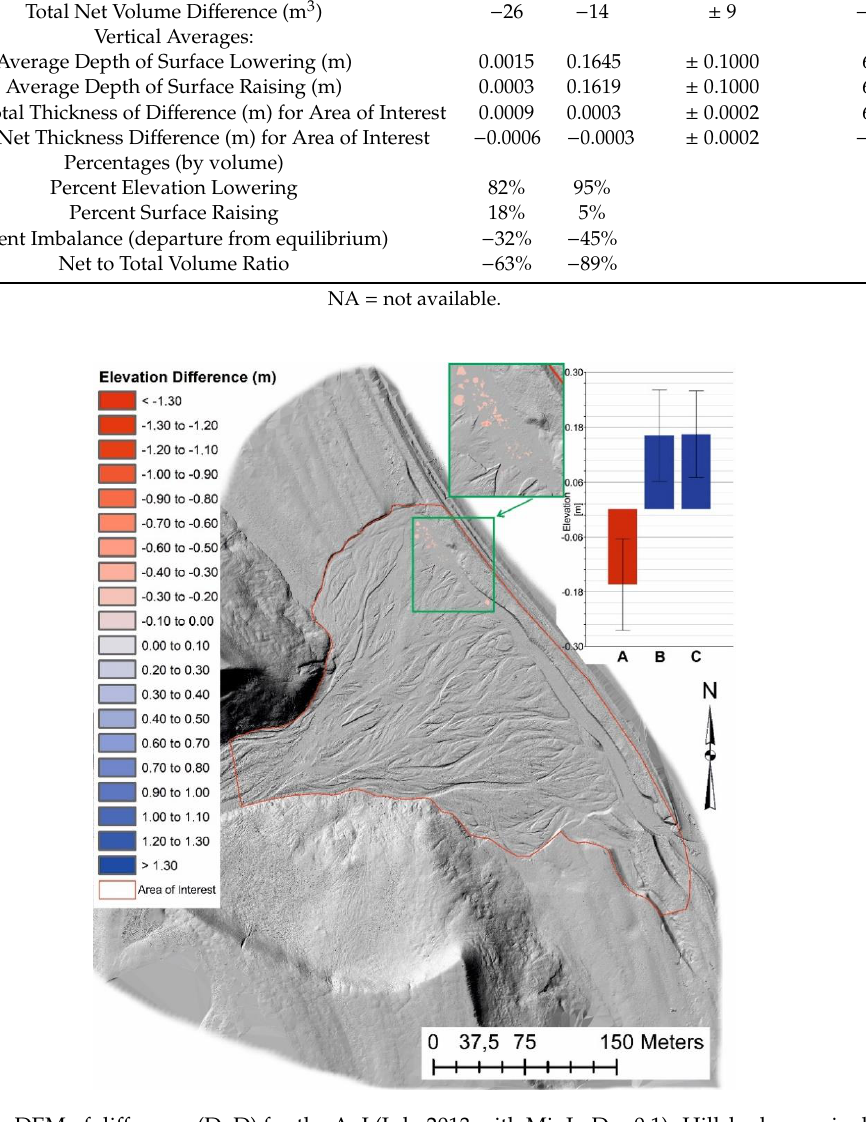
Figure 5. DEM of difference (DoD) for the AoI (July 2013 with MinLoD = 0.1). Hillshade map is shown behind the DoD for context. Description of the bars in the diagram: (A) Average Depth of Lowering; (B) Average Depth of Raising; (C) Average Total Thickness Difference.